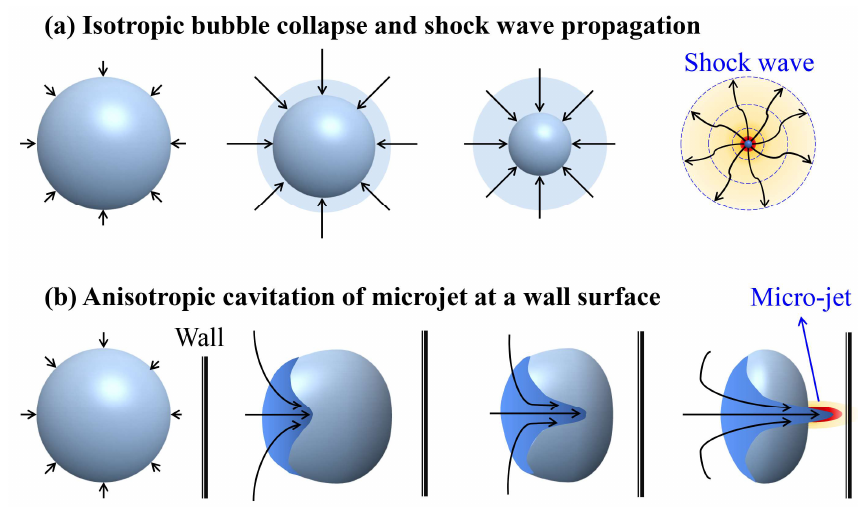
Figure 7. Diagram of ( a ) shock wave and (b) microjet generated by cavitation bubble collapse. Remodified from Kim et al. [49].